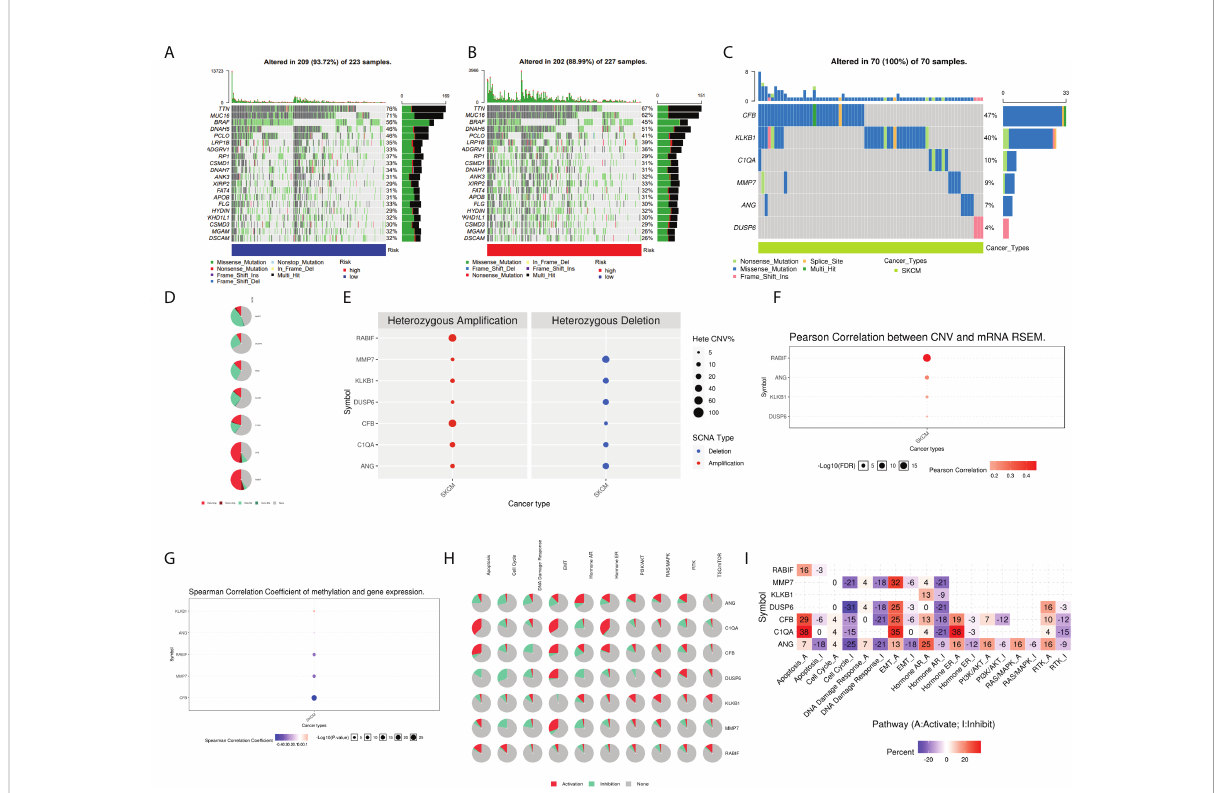
FIGURE 9 Analysis of ANG, CIQA, CB, DUSP6, KLKB1, MMP7, and RABIF using GSCAlite. (A) The oncoplot, commonly called the waterfall plot, depicts the distribution of mutations and SNV types ’ classi fi cation (which includes missense mutations, frameshift deletions, nonsense mutations, and so on) for the seven genes in the patient samples of SKCM. The side bar graph and top bar graph present the number of mutations in each sample or gene. (B, C) Oncoplots display the somatic landscape of SKCM with high- and low-risk group. (D) Heterozygous CNV pro fi le presents the percentage of heterozygous CNVs, including the percentage of heterozygous ampli fi cation and deletion of these genes in SKCM. (E) CNV pie distribution. (F) Relationship between CNV and gene expression. Red bubbles demonstrate positive correlation, meaning that the gene expression will become upregulated when genes have high frequency of CNV. The darker the color, the higher the correlation. The size of the dots demonstrates statistical signi fi cance: the statistical signi fi cance increases as the sample size grows. (G) Correlation analysis among the gene expression levels and methylation. Down-regulated methylation in tumors is represented by blue dots, while up-regulated methylation in tumors is represented by red dots. (H) Pie-shaped distribution of the above 7 genes in cancer pathway, red depicts activation, green represents suppression; (I) Percentages of these genes in cancer pathway (I depicts suppression; A depicts activation), darker color depicts higher percentage. SNV, single nucleotide variation. CNV, copy number